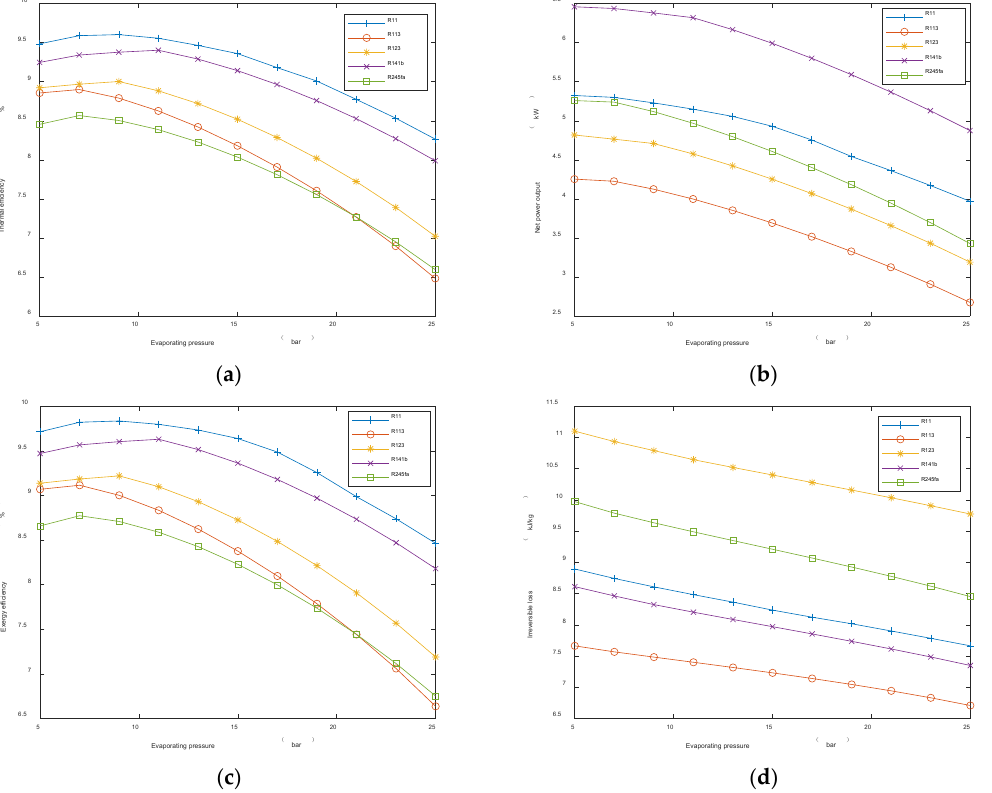
Figure 8. The influence diagram of the evaporation pressure of different organic working fluids on system performance. ( a ) Effect of evaporation pressure of different organic working fluids on thermal efficiency; ( b ) Effect of evaporation pressure of different organic working fluids on net output power; ( c ) Effect of evaporation pressure of different organic working fluids on exergy efficiency ( d ) Effect of evaporation pressure of different organic working fluids on irreversible loss.